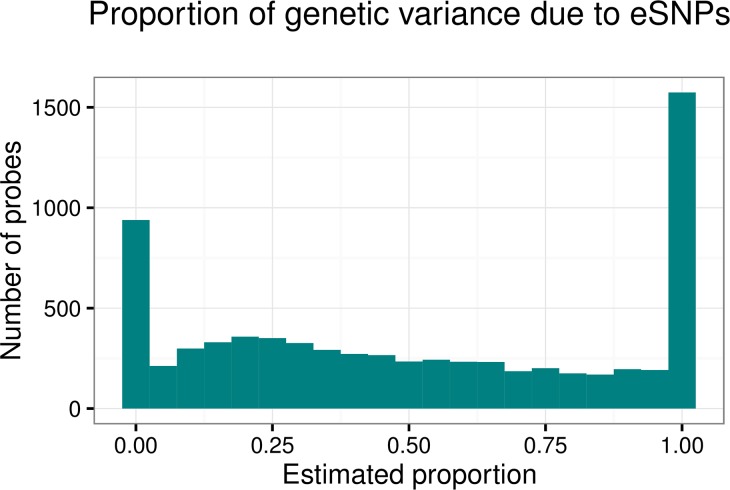
Distribution of proportion of genetic variance due to eSNPs.Proportion of genetic variance due to eSNPs (estimated as 1—the ratio of the genetic variance component when eSNPs are included as fixed effects to the genetic variance component when eSNPs are not included) for the 7,280 heritable probes with local or distal associations, assuming values less than 0 (12%) are exactly 0.